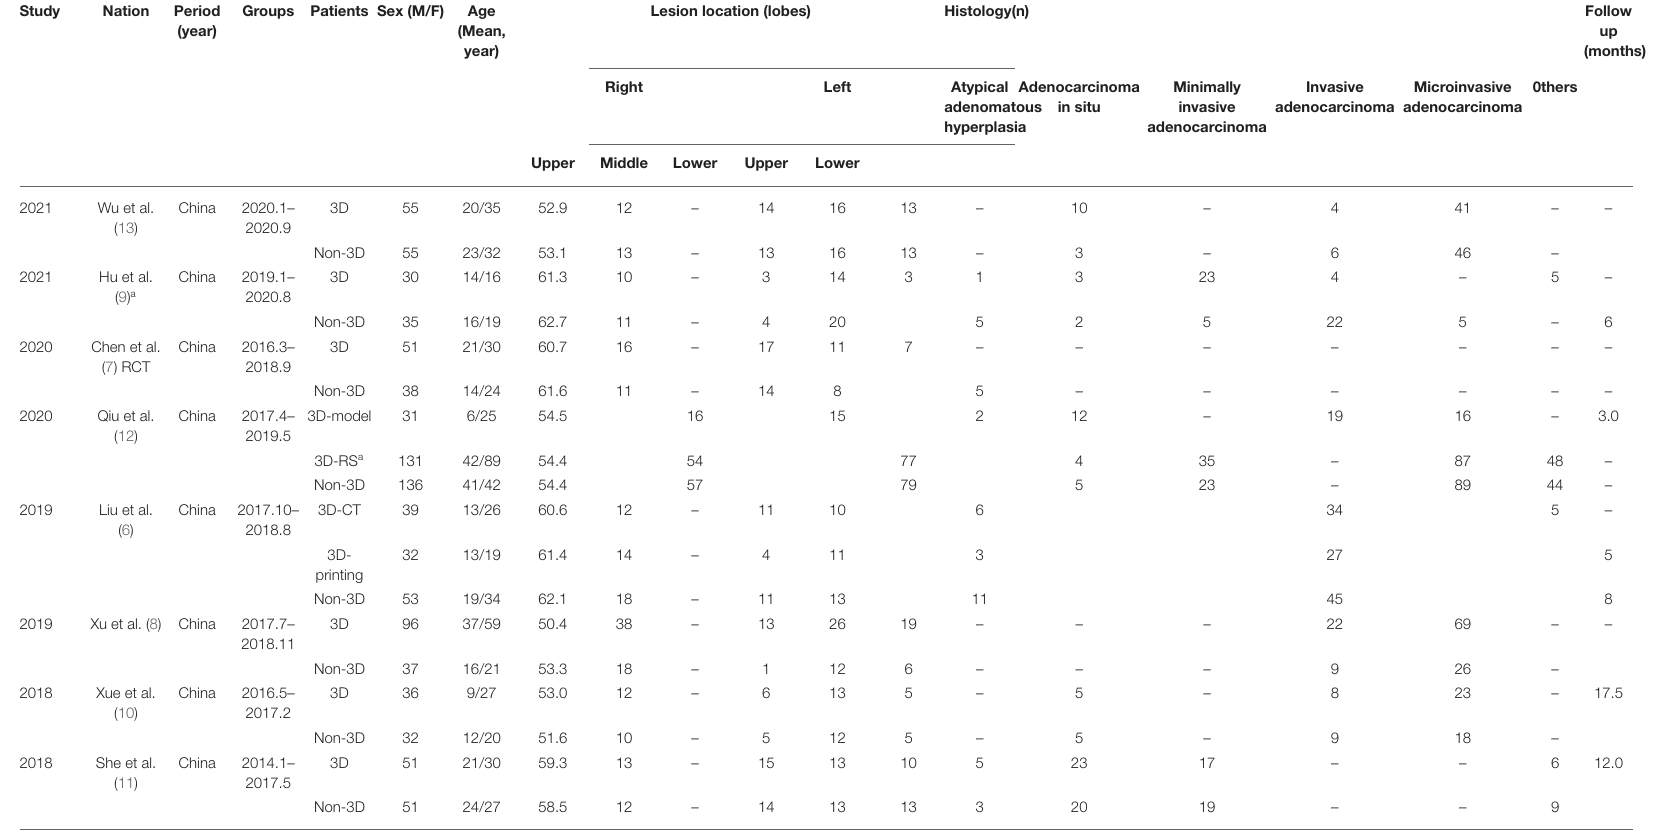
TABLE 1 | Summary of the baseline characteristics of the included studies.